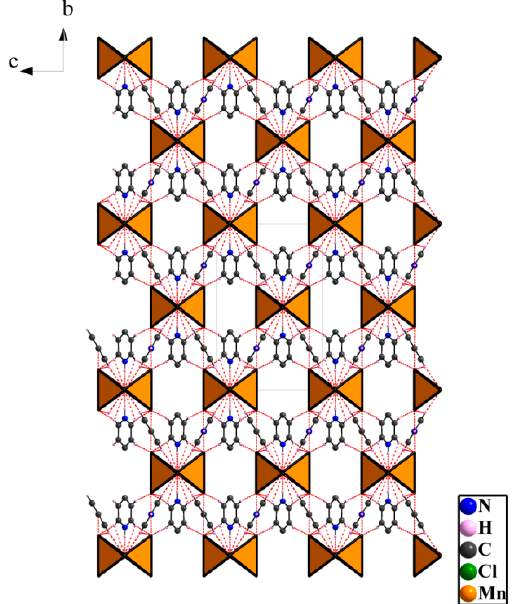
Figure 3. Projection along the a- axes of compounds ( I ) and ( II ); the only difference is in the orientation of the organic cations (the tert-butyl groups have been omitted for clarity).